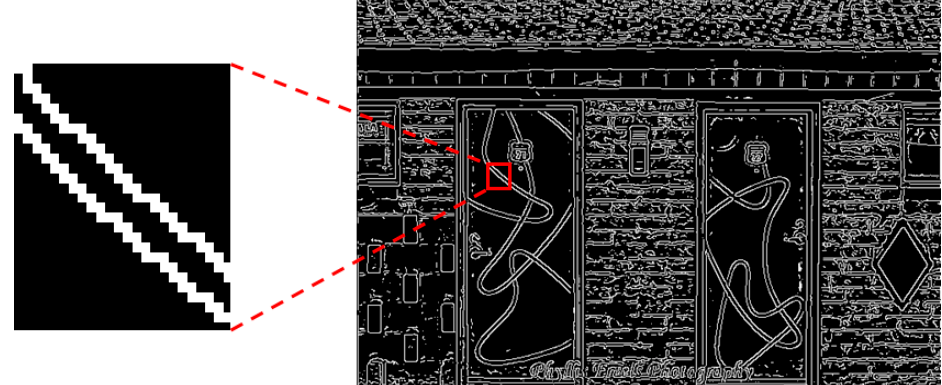
Figure 6. Candidate edge image after non-maximum suppression.